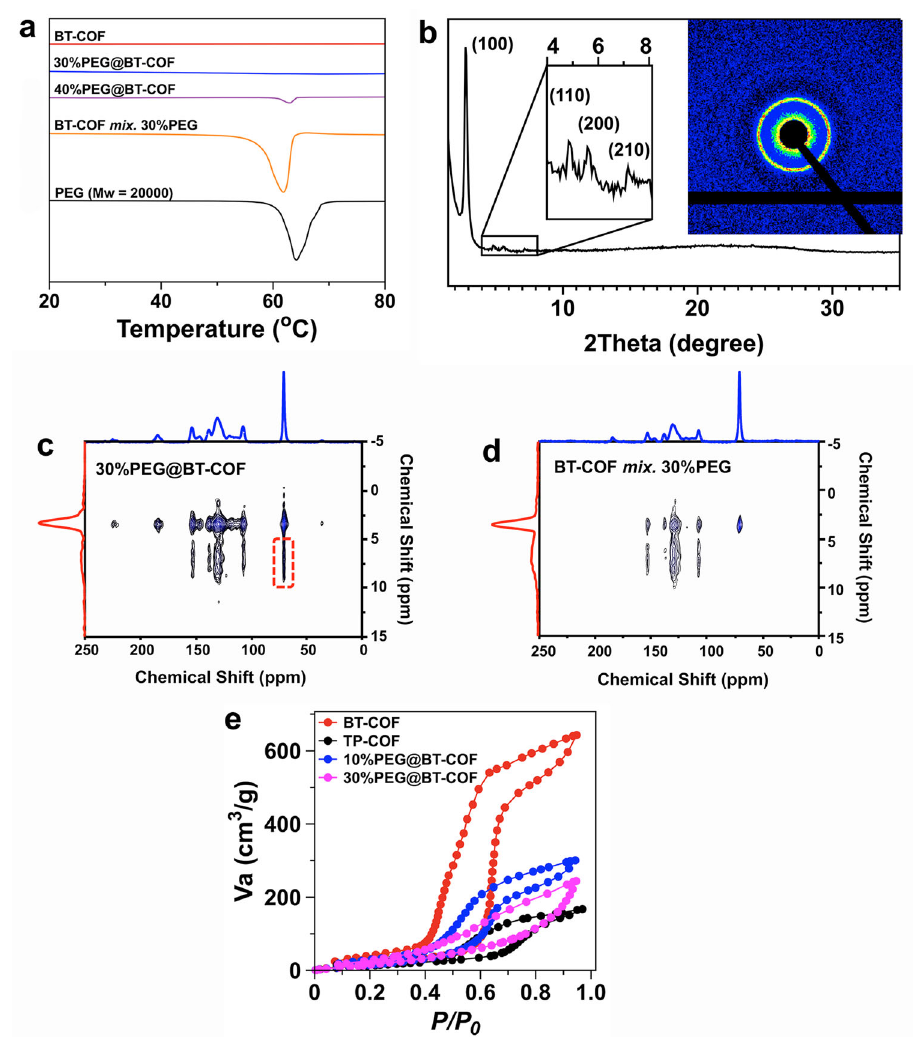
Fig. 2 DSC pro fi les, NMR spectrum, WAXS pattern, and water vapor uptake pro fi les. a DSC pro fi les of BT-COF, PEG, 30%PEG@BT-COF, 40%PEG@BT- COF, and the mixture of 30%PEG and BT-COF. b WAXS pro fi le of 30%PEG@BT-COF (inset: two-dimensional WAXS pattern). c , d Solid-state 2D 1 H- 13 C HETCOR NMR spectra of c 30%PEG@BT-COF and d a mixture of BT-COF and 30 wt%PEG. e Water uptake pro fi les of BT-COF, TP-COF, 10%PEG@BT- COF, and 30%PEG@BT-COF at 298 K,